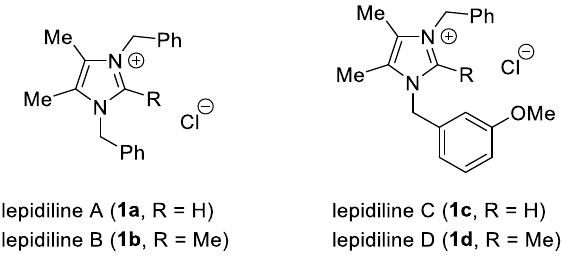
Figure 1. Structures of naturally occurring alkaloids known as lepidilines (A – D).